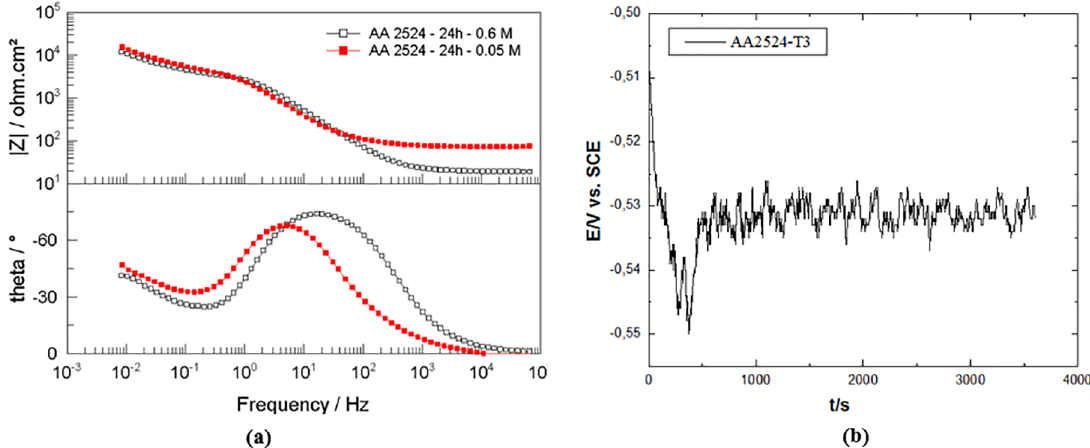
Figure 5. (a) Comparison of the data obtained for alloy AA2524-T3 in this work (mol L -1 ) and the data obtained by Moreto et al 12 in 0.6 mol L -1 NaCl solution after 24 h exposure and (b) evolution potential with time for the first hours of tests.